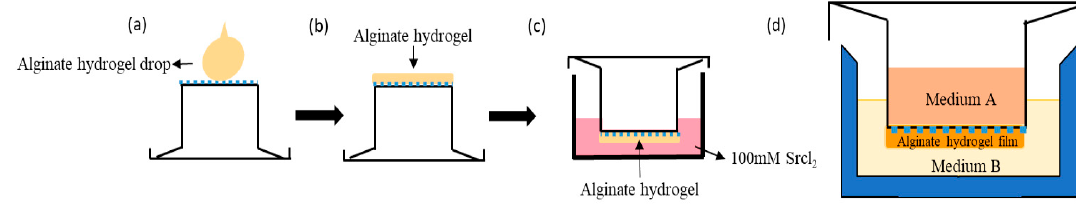
Figure 1. Schematic of transwell-based alginate hydrogel (TAH) apparatus and principle of curing. ( a ) Apply 4% sodium alginate on the membrane of transwell. ( b ) Spread alginate hydrogel equally. ( c ) Invert the transwell in a well with 100 mM SrCl 2 for curing overnight. ( d ) Assemble a TAH platform by the transwell and a 24-well plate containing breast cancer cells and the medium.